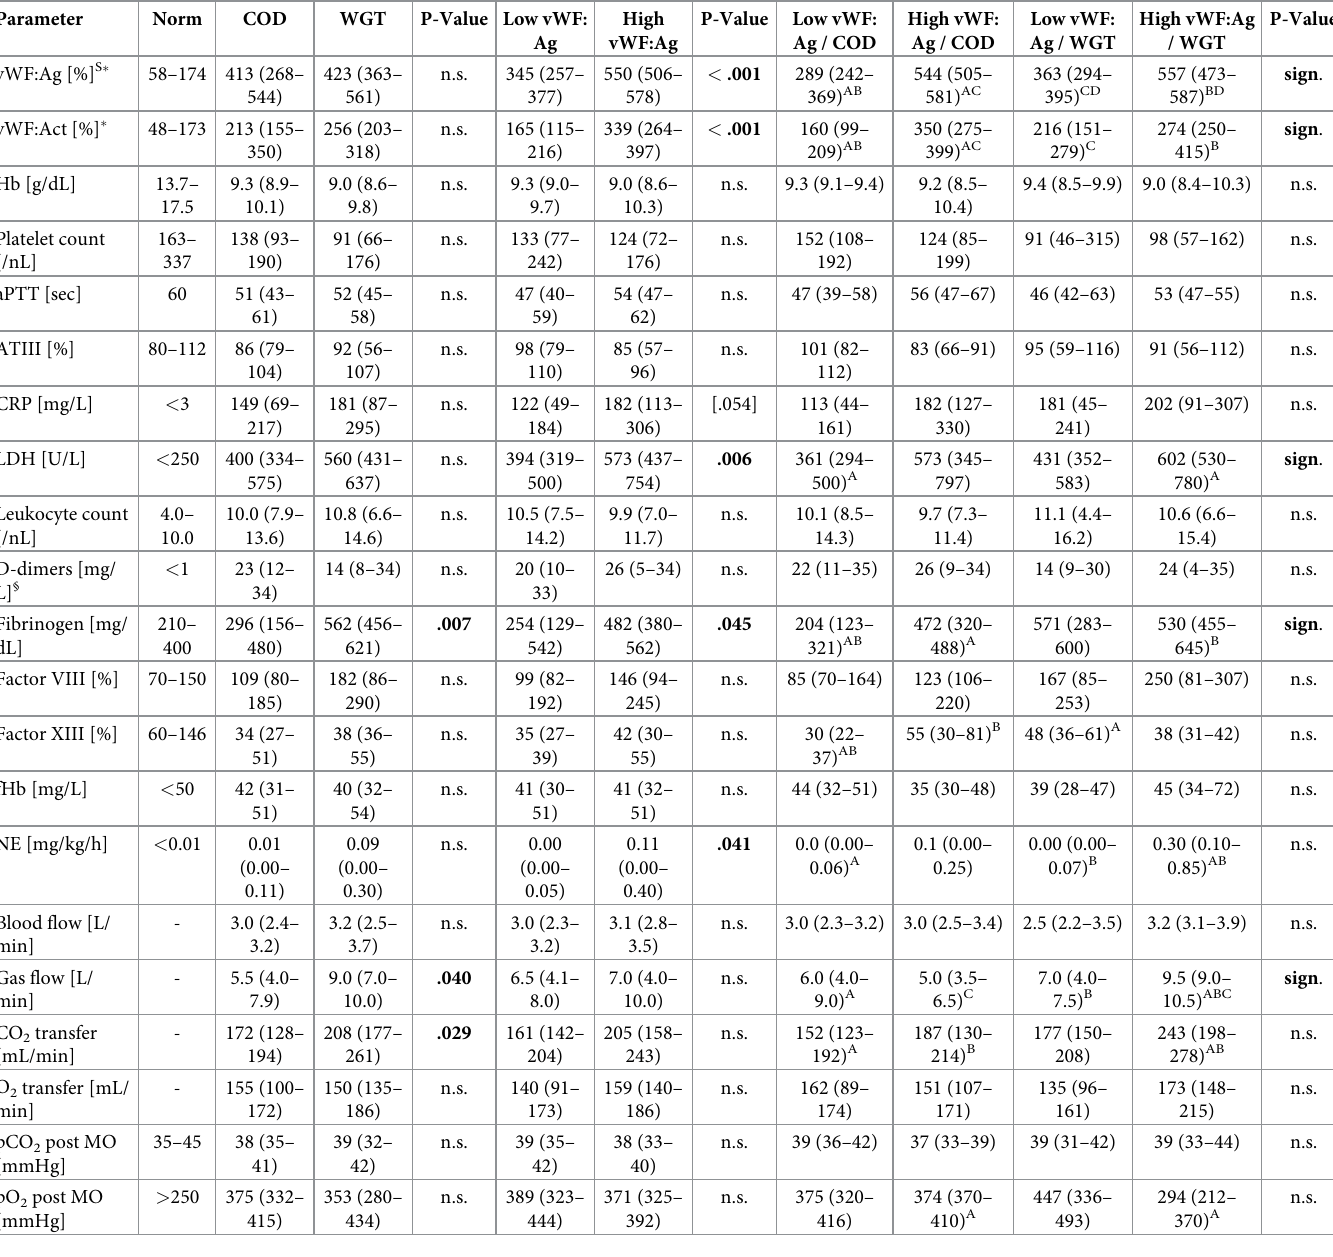
Table 2. Ventilation-related data and laboratory parameters over 3 days before the MO was